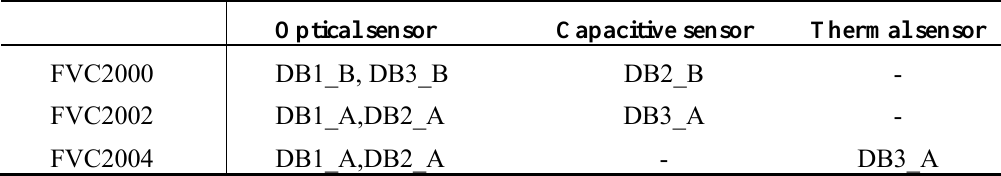
Table 3 . Information on the capture sensor of the